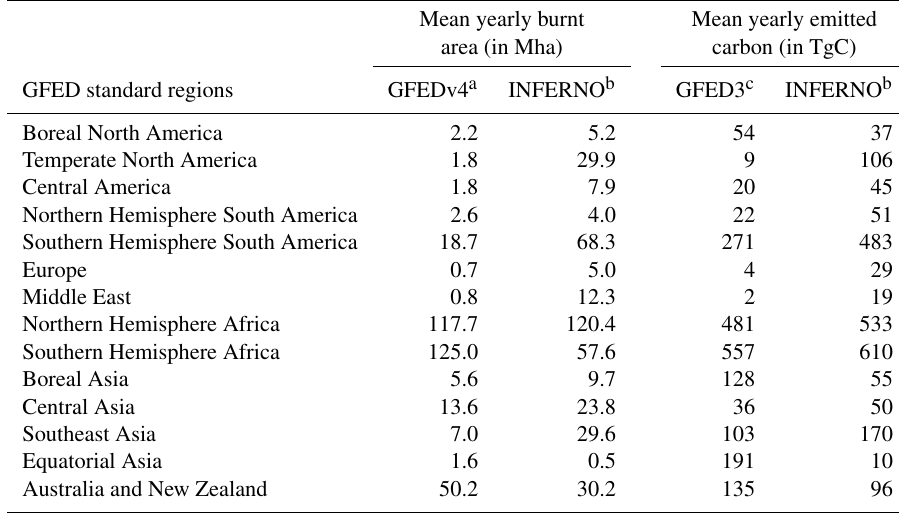
Table B1. Regional budgets according to the standard GFED regions (van der Werf et al.,